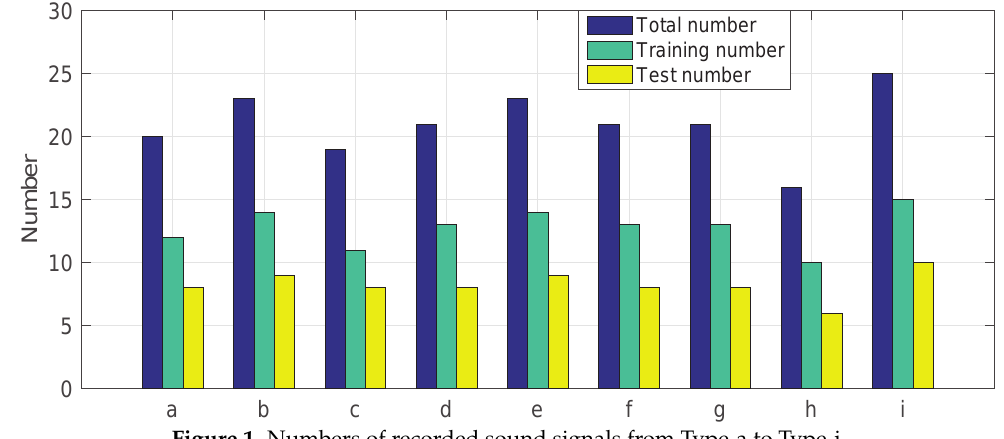
Figure 1. Numbers of recorded sound signals from Type-a to